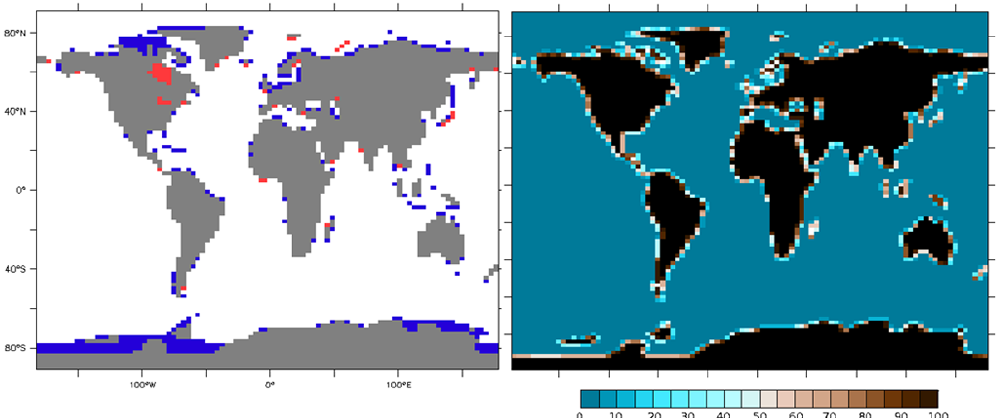
Fig. 1. Difference between present land-sea mask and mPWP land-sea mask (left). Blue grid cells are land in the present mask (i.e. land fraction superior or equal to 50%), but ocean in the mPWP mask. Red grid cells are ocean in the present mask and land in the mPWP mask. Land percentage on each grid cell for the “preferred” simulation (right).